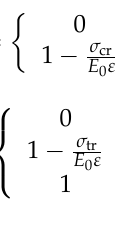
Figure 2. Elastic–brittle damage constitutive law of the micro element.